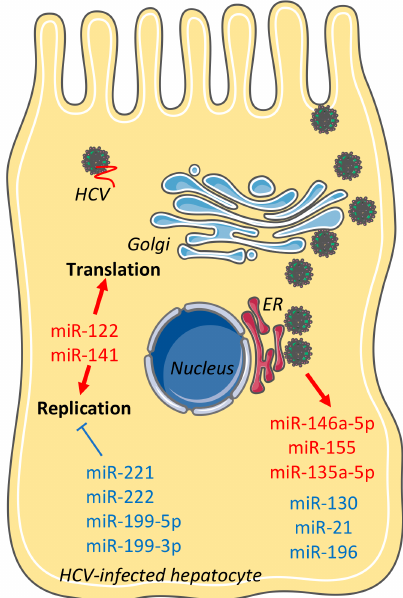
Figure 1. Impact of cellular miRNAs on the HCV life cycle and their contribution to HCV-induced HCC. Impact of individual miRNAs whose expression is modulated upon HCV infection on steps of the HCV life cycle (entry, translation, replication, assembly, and LVP release) are shown. miRNAs in blue display a proviral effect; miRNAs in red have an antiviral effect. HCV: hepatitis C virus. LVP: lipoviral particle. ER: endoplasmic reticulum. Golgi: Golgi apparatus. Images were adapted from SMART (Servier Medical